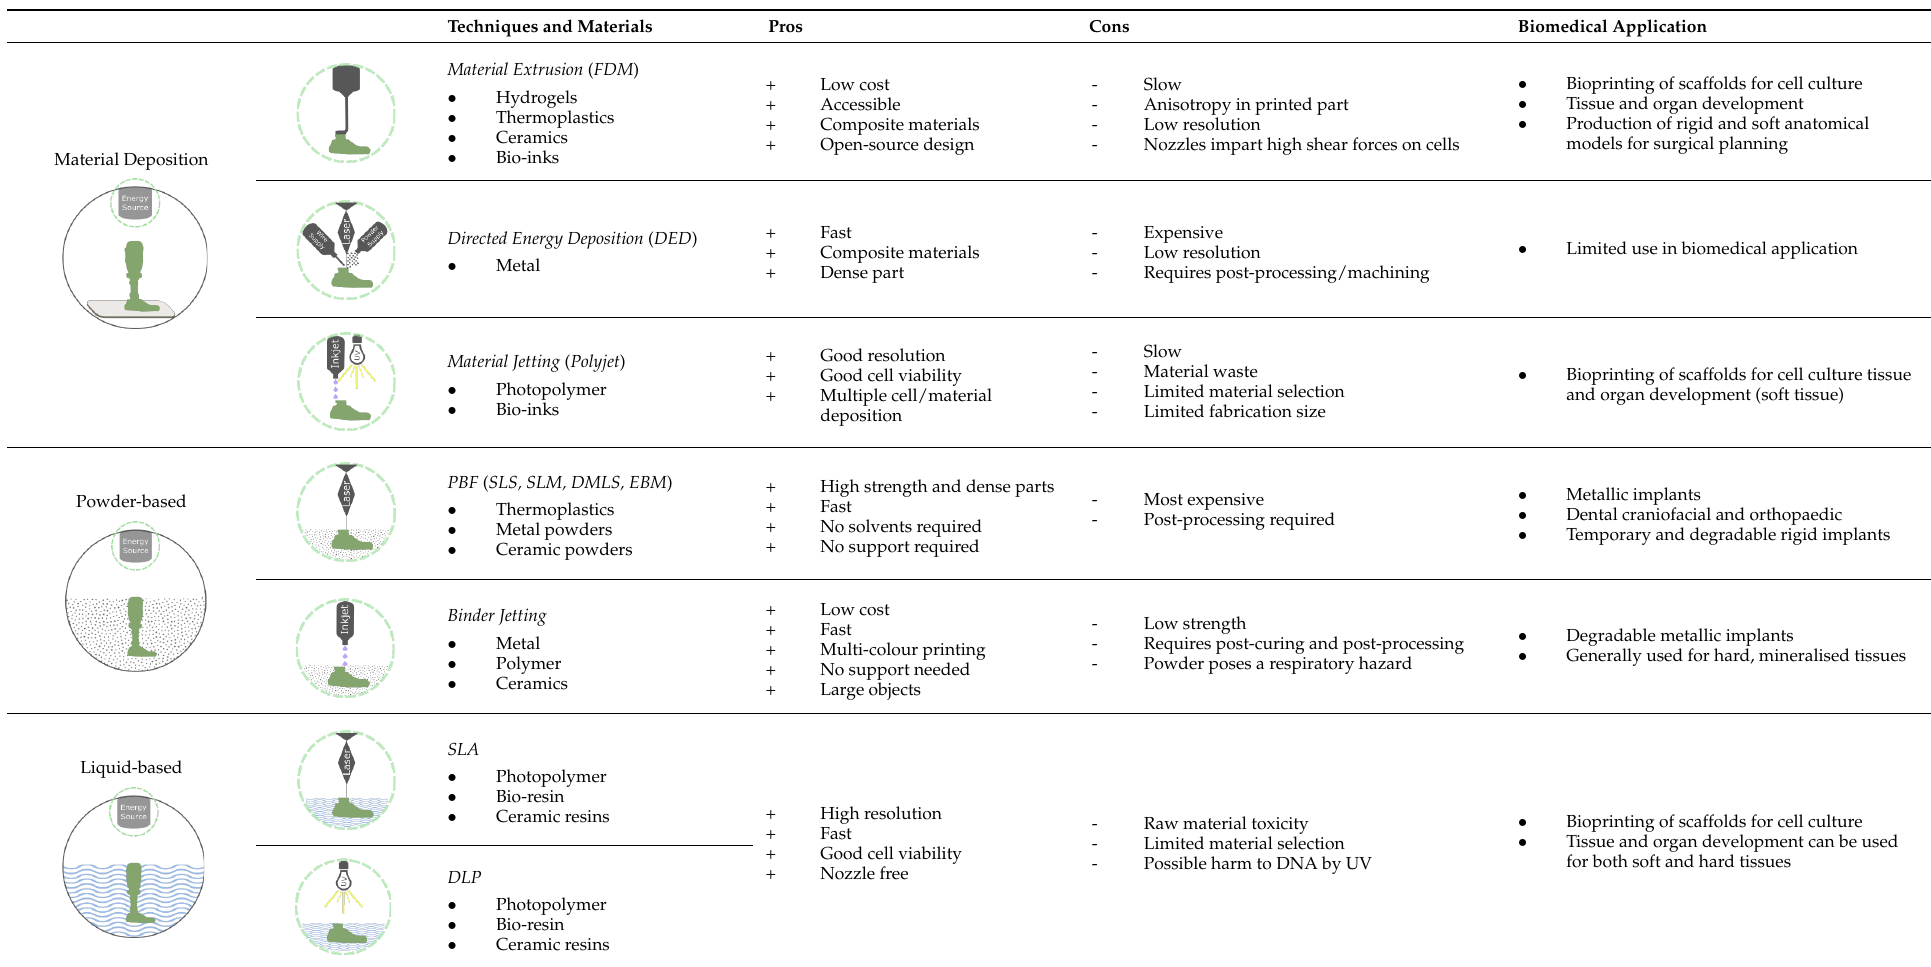
Table 1. Summary of the different AM techniques, useable materials, their pros and cons, and their biomedical